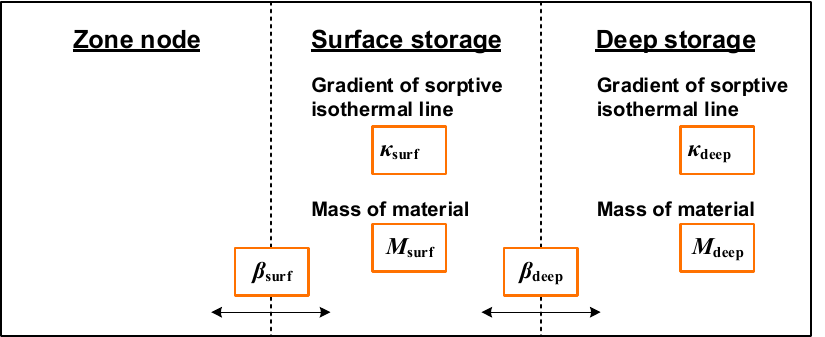
Figure 4. Conceptual diagram of the Buffer Storage Humidity Model.